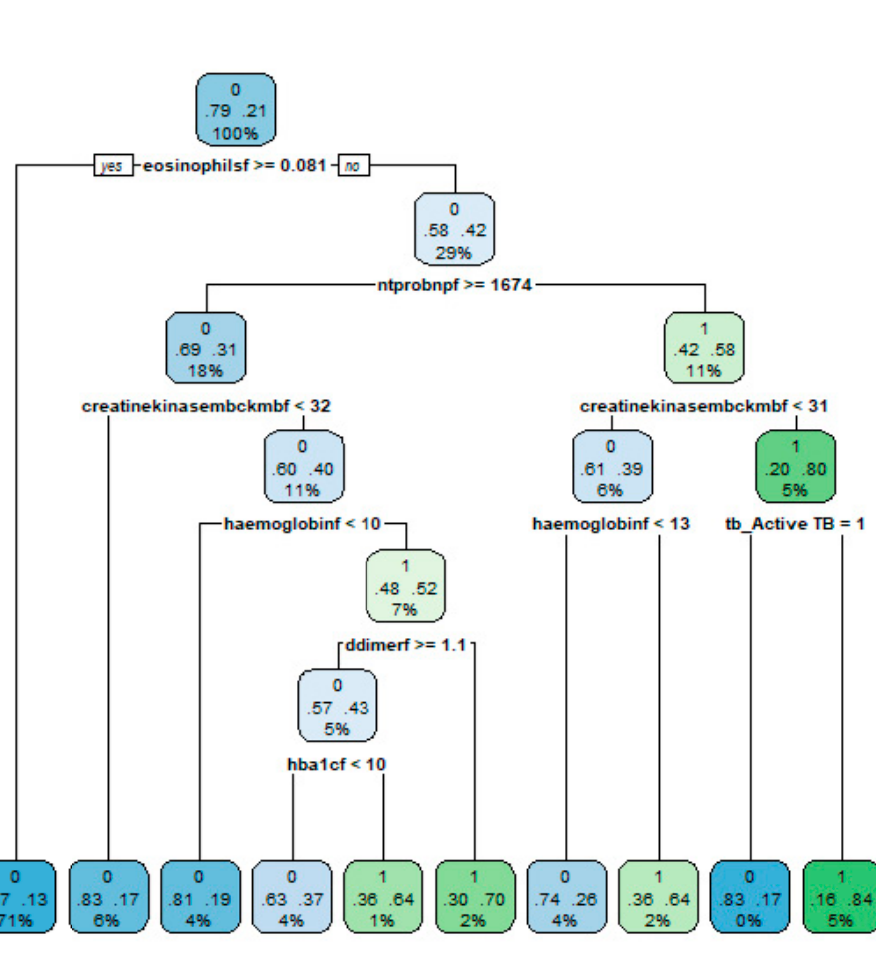
Figure 9. Decision Tree for risk stratification